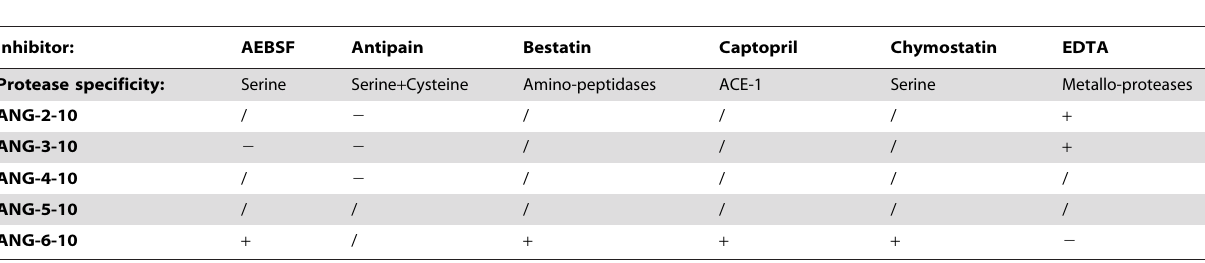
Table 1. List of different inhibitors used for characterization of angiotensin-generating proteases.